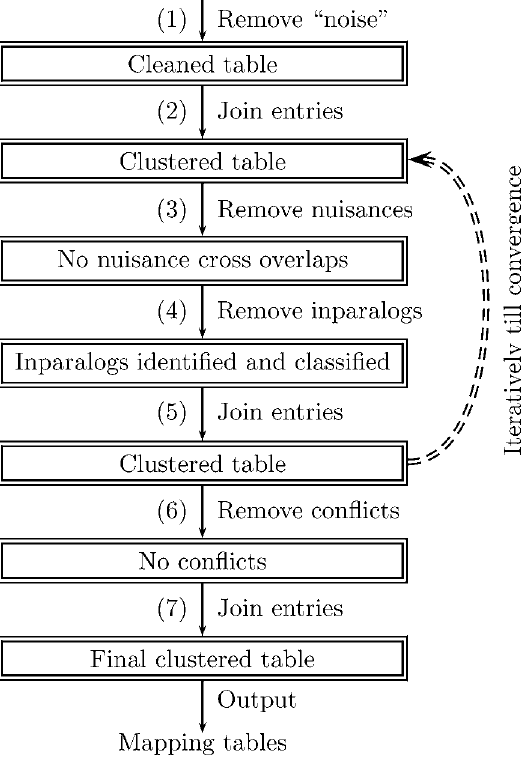
Figure 3. A Flow Diagram of MAGIC (A) A flow diagram of the preprocessing phase (see Preprocessing Phase: Building a Comprehensive Table of Similar Segments). (A1) A one-to-one table (anchors) between two genomes is used to calculate runs of anchors corresponding to potentially similar segments. (A2) These segments are globally aligned to validate their similarity and to find unmatched regions (these regions are candidates for indels or reordering